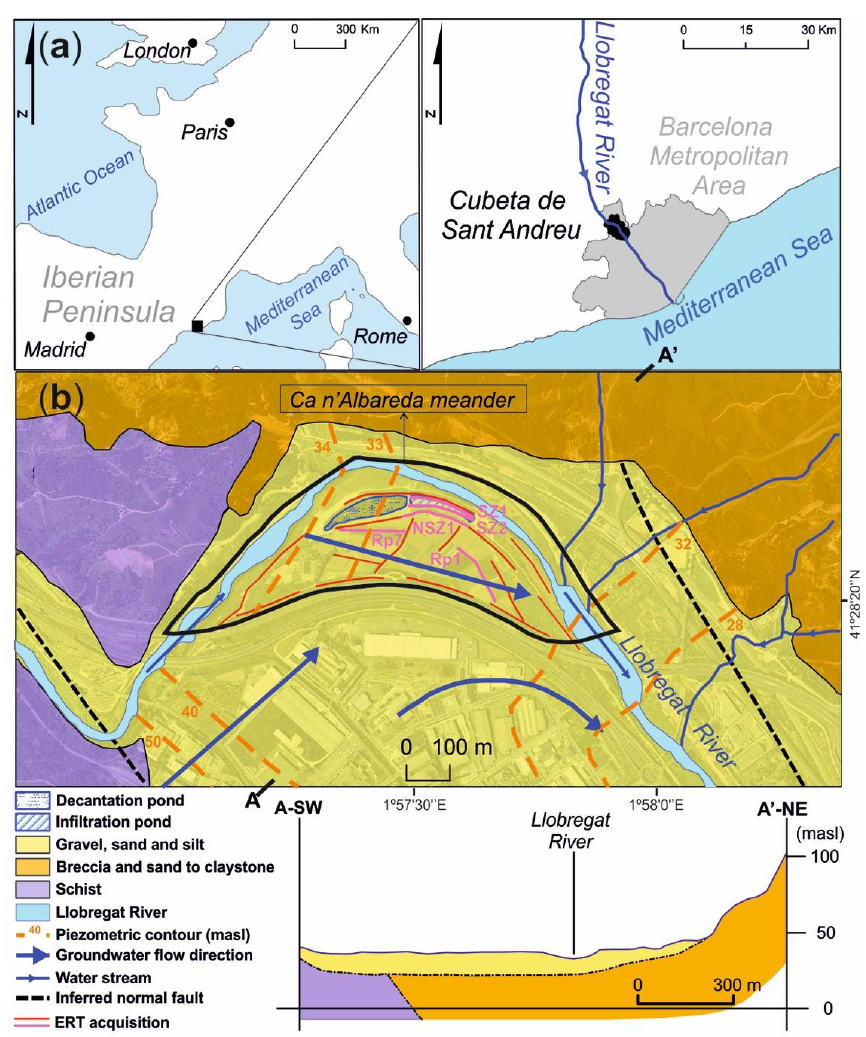
Figure 1. ( a ) Location sketch of the Cubeta de Sant Andreu basin, ( b ) hydrogeological setting of the Ca n’Albareda’s meander and recharge ponds. Modified from Reference [35]. Electrical resistivity tomography (ERT) locations presented in this paper are quoted in light